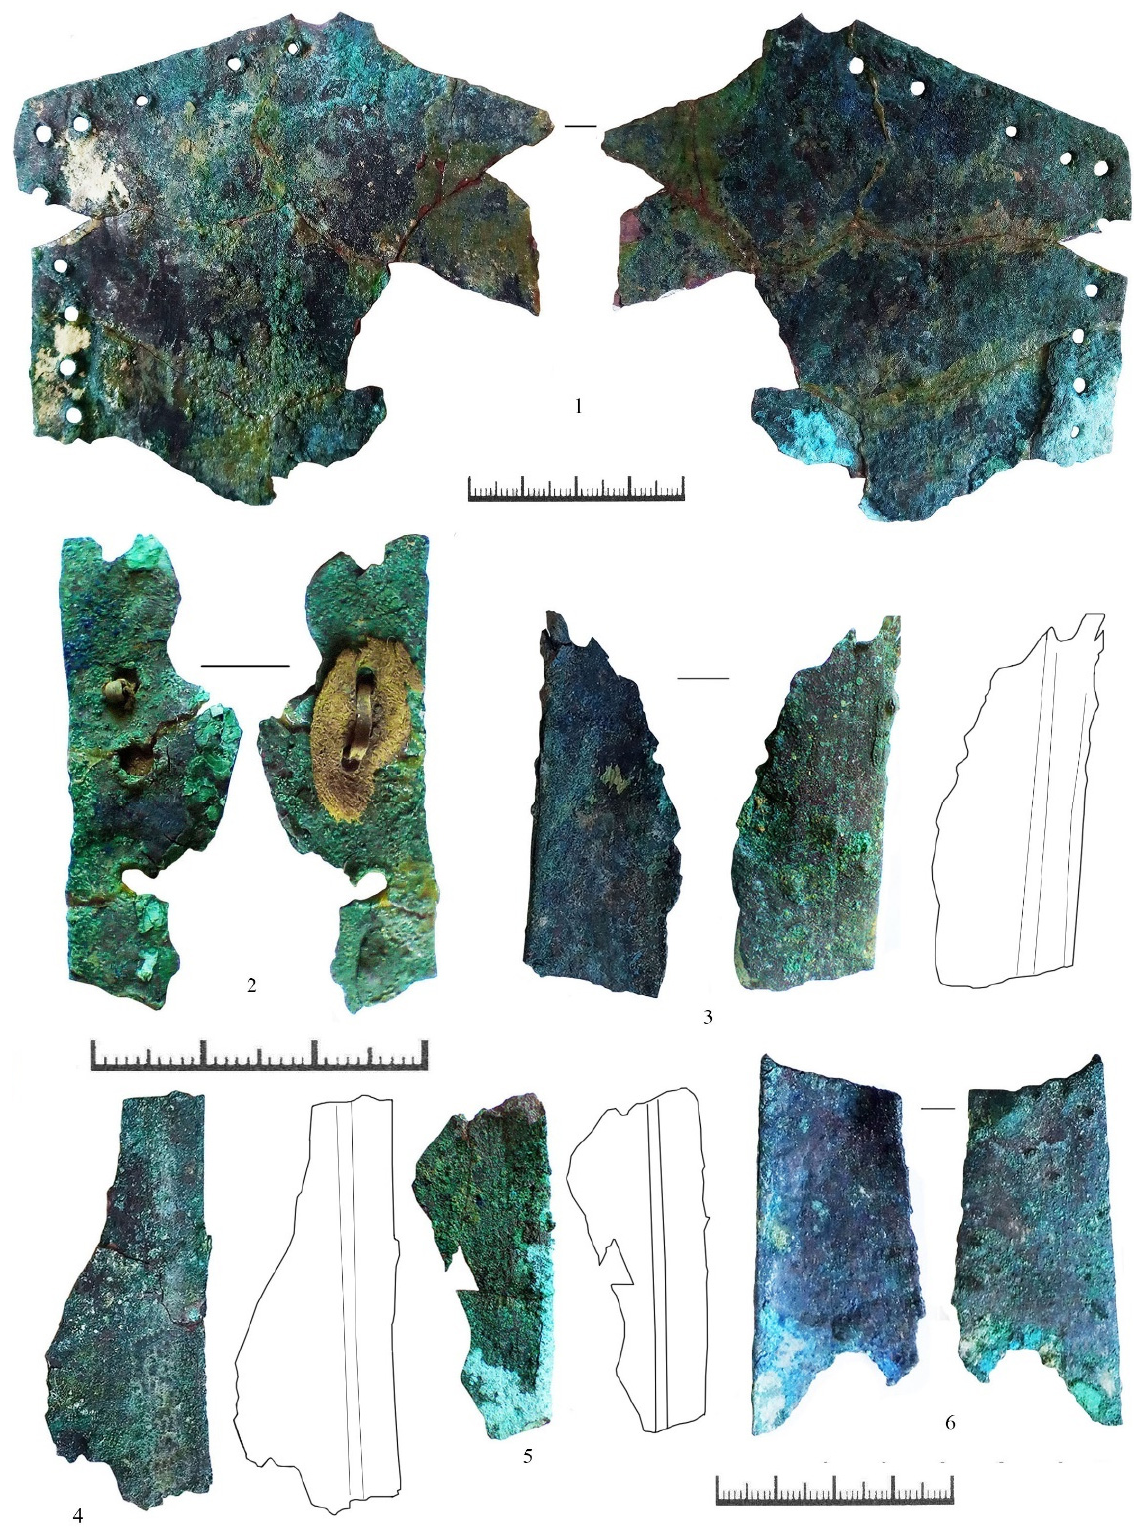
Figure 6. Vodoslavka Barrow 6 Burials 1–2. The left greave. (1)—Left side corner. (2)—Side edge with inner leather lining sewn on. (3)–(6)—Fragments of the lower part of the side edges of the greaves (photograph М . Daragan).